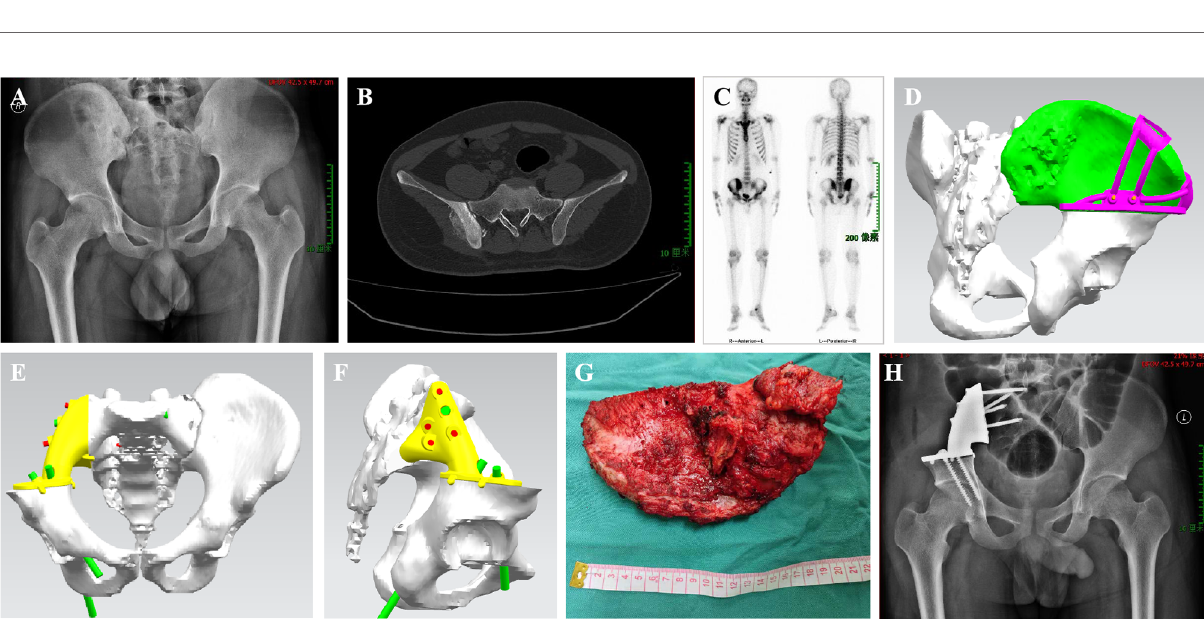
(D – F) A 3D-printed model is used for osteotomy guide-assisted resection of the tumor and simulates the installation of the prosthesis. (G) A gross specimen of resected tumor. (H) Twenty-seven months postoperative X-ray shows stable internal fi xation.